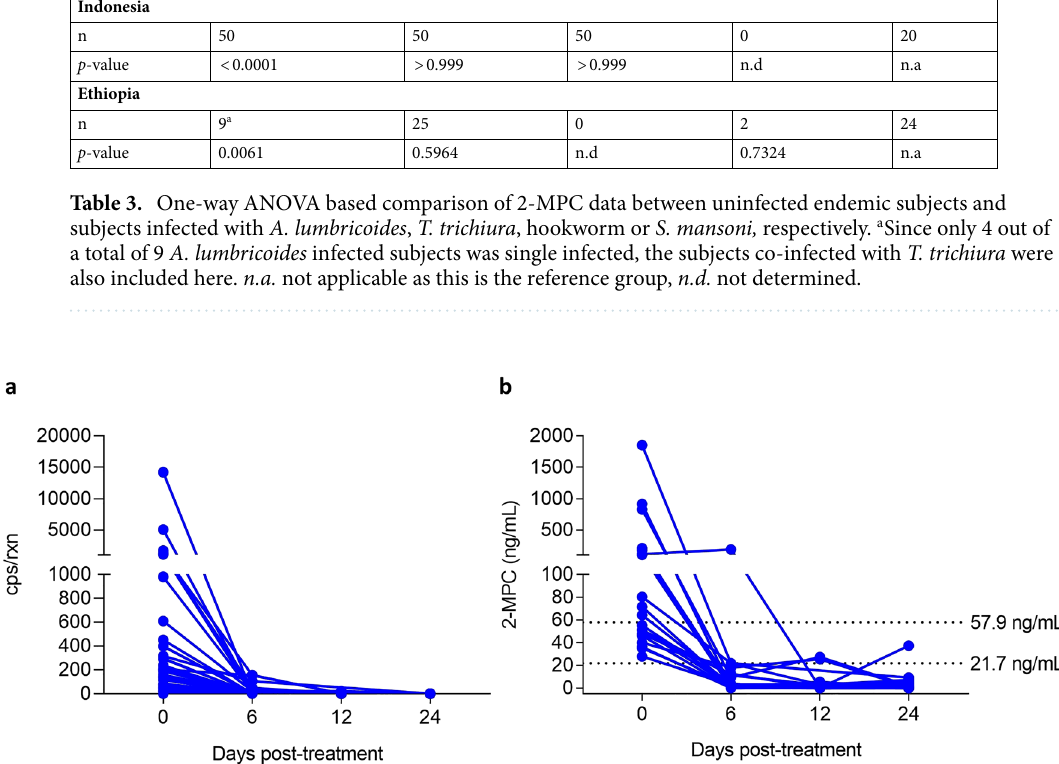
Figure 5. Effect of treatment with albendazole on the presence of Ascaris lumbricoides DNA in stool ( a ) and urinary 2-MPC ( b ). Stool and urine samples were collected before (Day 0) and at different timepoints after treatment with albendazole: 6 days, 12 days and 24 days after